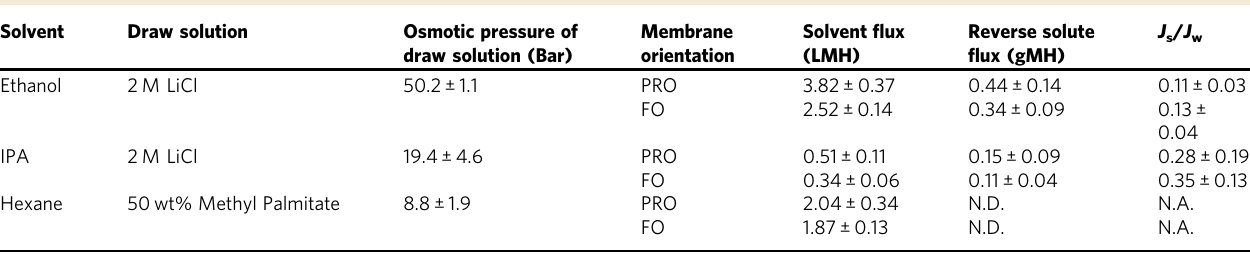
Table 1 Membrane performance in different solvent systems Solvent Draw solution Osmotic pressure of draw solution